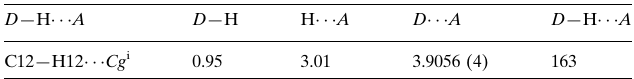
Hydrogen-bond geometry (A˚ , (cid:2)